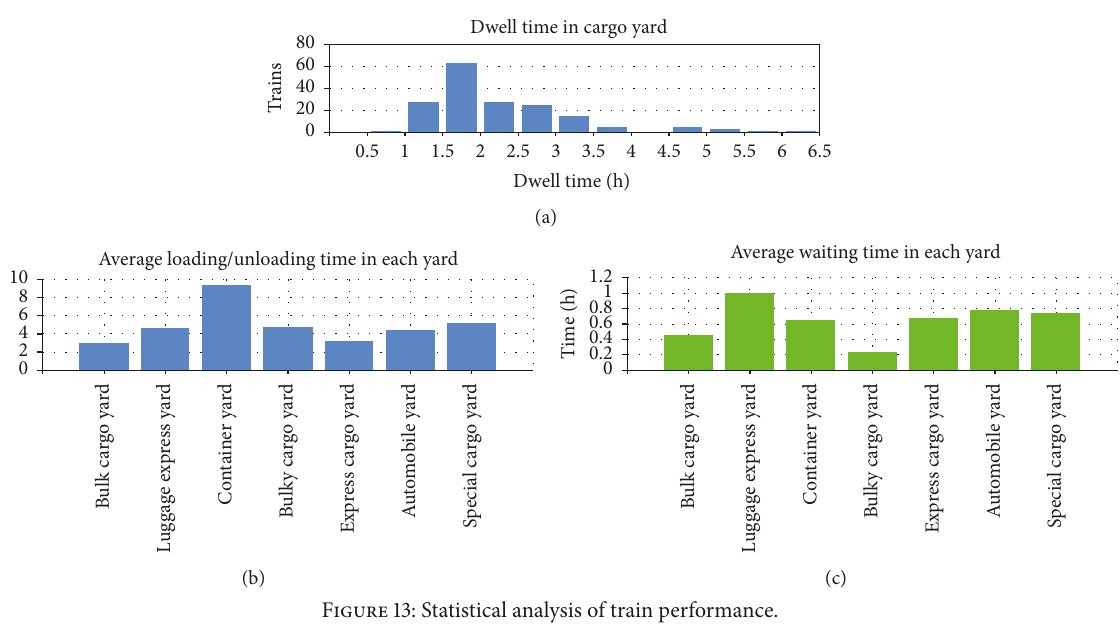
Figure 13: Statistical analysis of train performance.